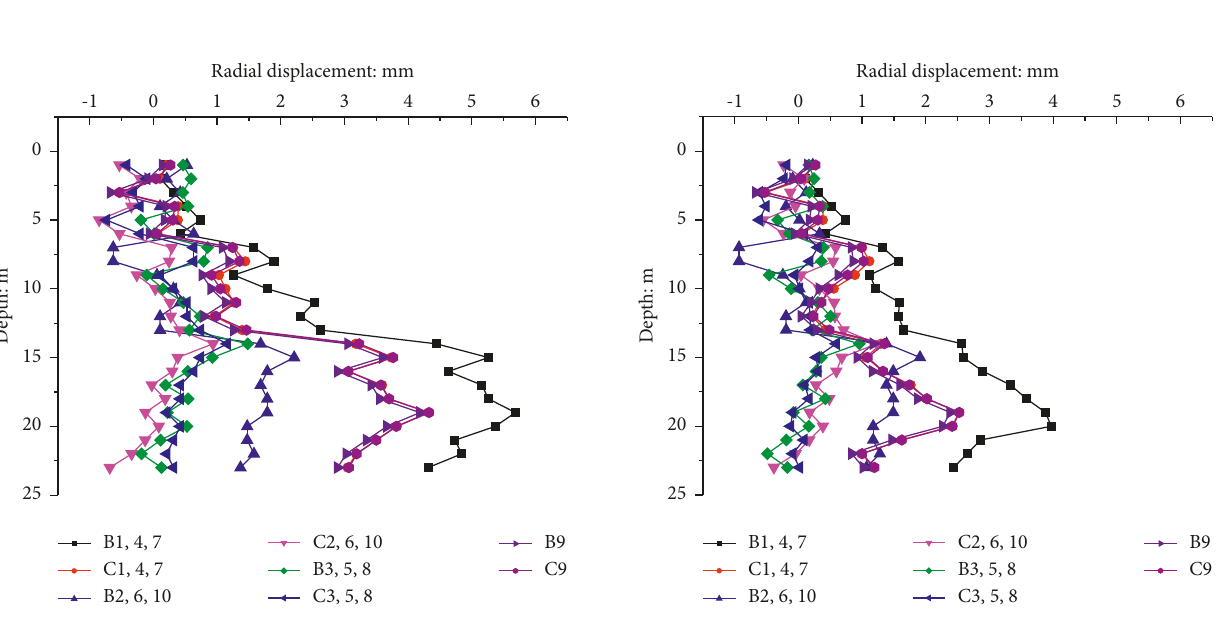
Figure 28: The horizontal displacement of # 1 measuring point changes with depth.